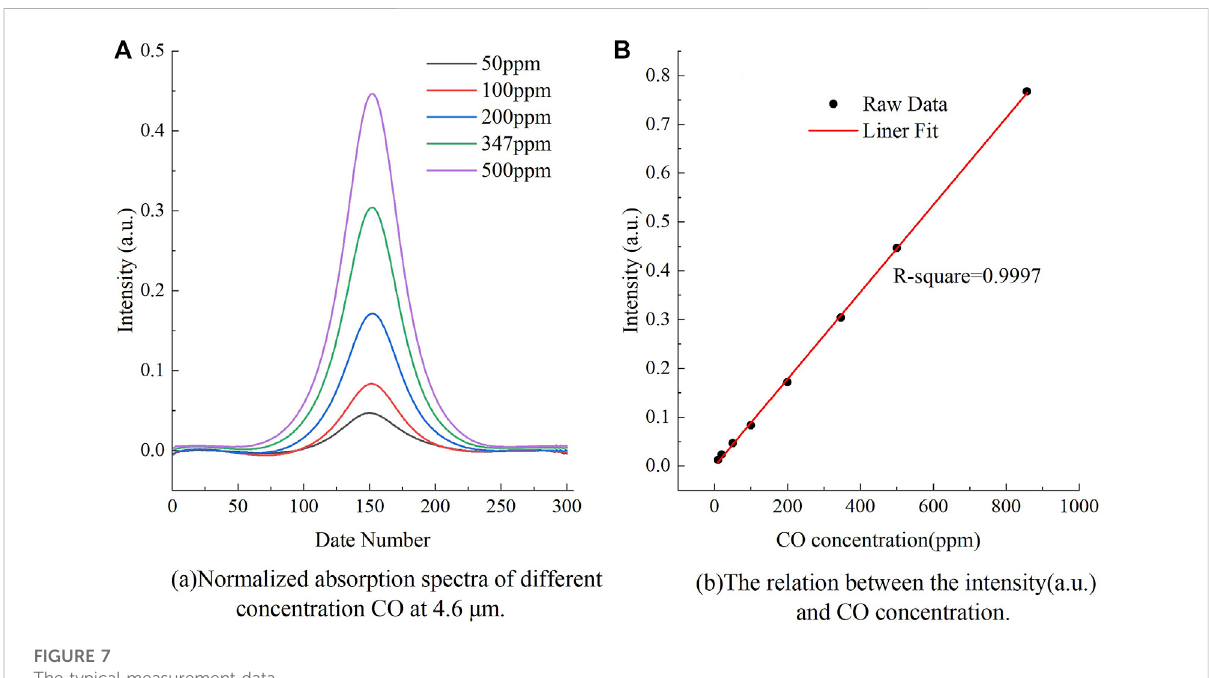
FIGURE 7 The typical measurement data.